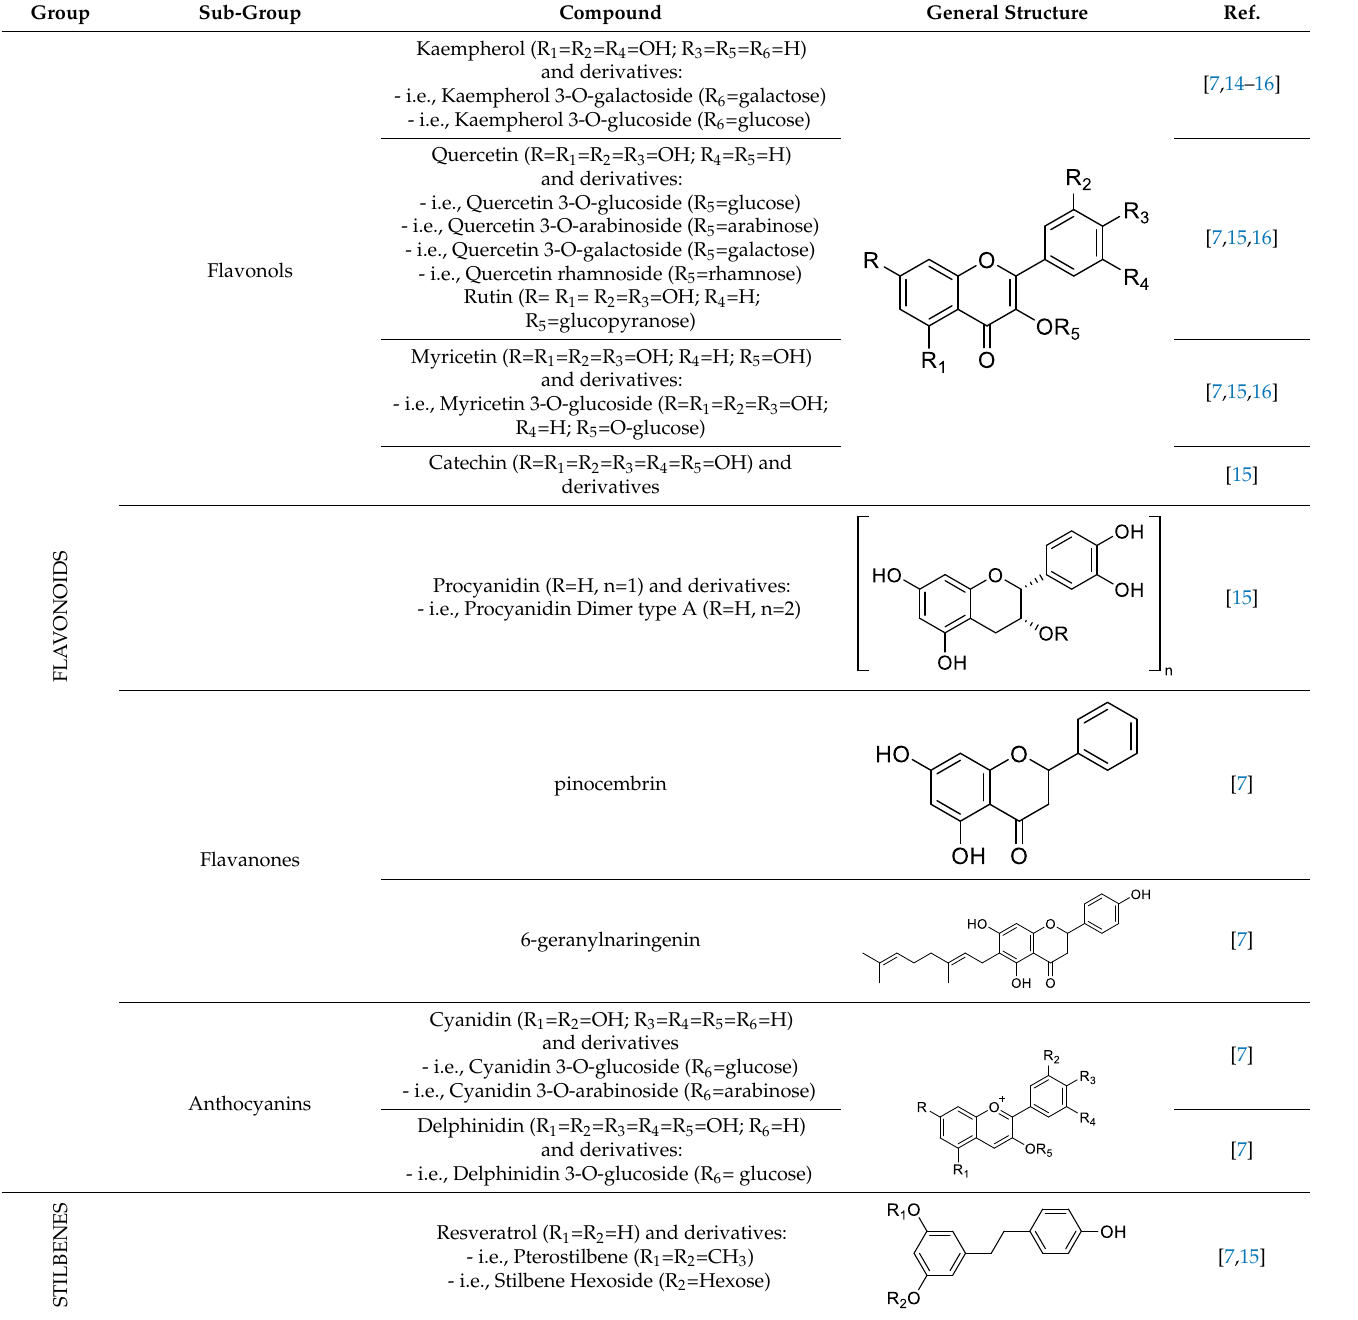
Resveratrol (R 1 =R 2 =H) and derivatives: - i.e., Pterostilbene (R 1 =R 2 =CH 3 ) Moreover, and in accordance with previously described features [20], natural phe- nolic acids, free or conjugated, can also appear as amides or esters whereas natural flavo- noids, free or conjugated, are often esterified to one or two sugar molecules (by one or more hydroxyl groups). Table 2. Phenolic compounds identified in C. album leaves. General Structure